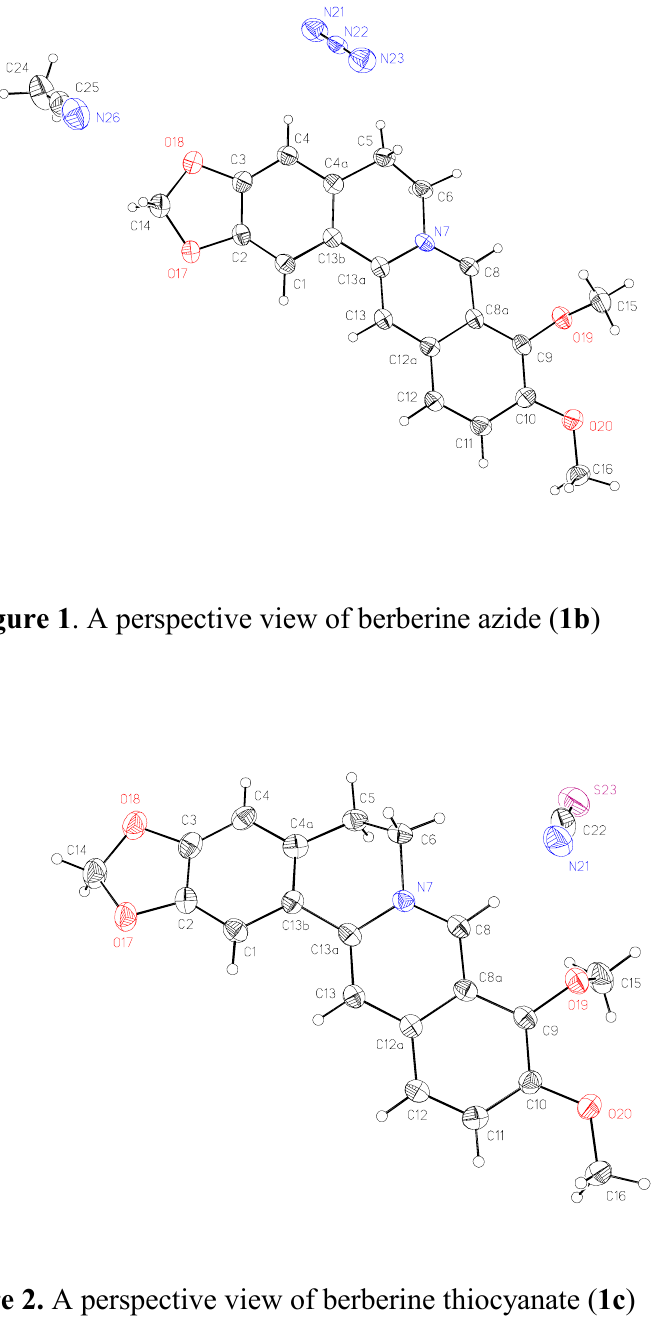
Figure 2. A perspective view of berberine thiocyanate ( 1c